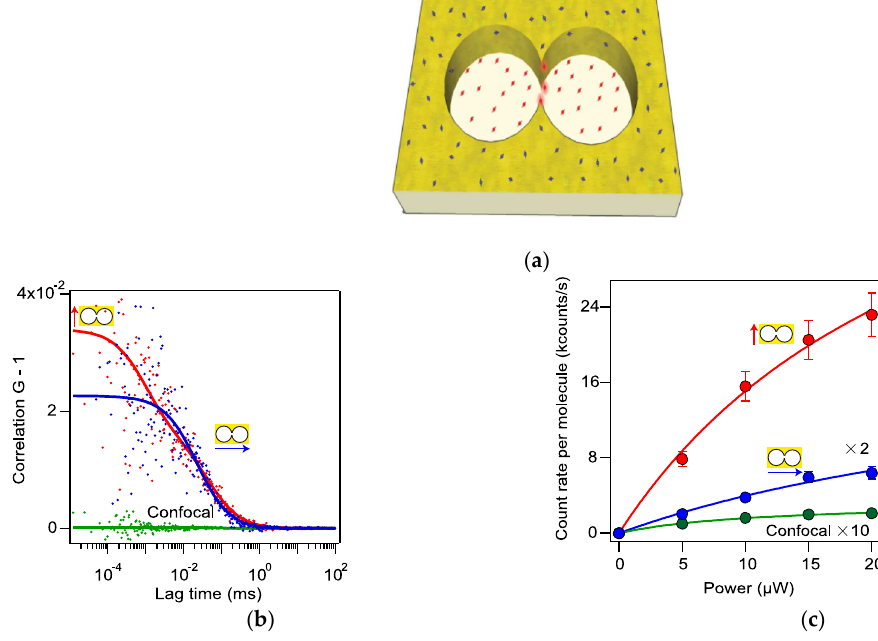
Figure 5. ( a ) Sketch of a double nanohole under an incident light polarized along with the two tips. ( b ) Fluorescence correlation spectroscopies for with double nanohole using incident light polarized parallel (red color) and perpendicular (blue color) to the apex region, and with a confocal microscope (green color). Dotted data is the measurement result and the solid curve is the corresponding fitting result for each case. ( c ) Comparison in brightness of fluorescence among these three cases at different incident power. Adapted from [82], with permission © 2015 Springer Nature Publishing A.G.